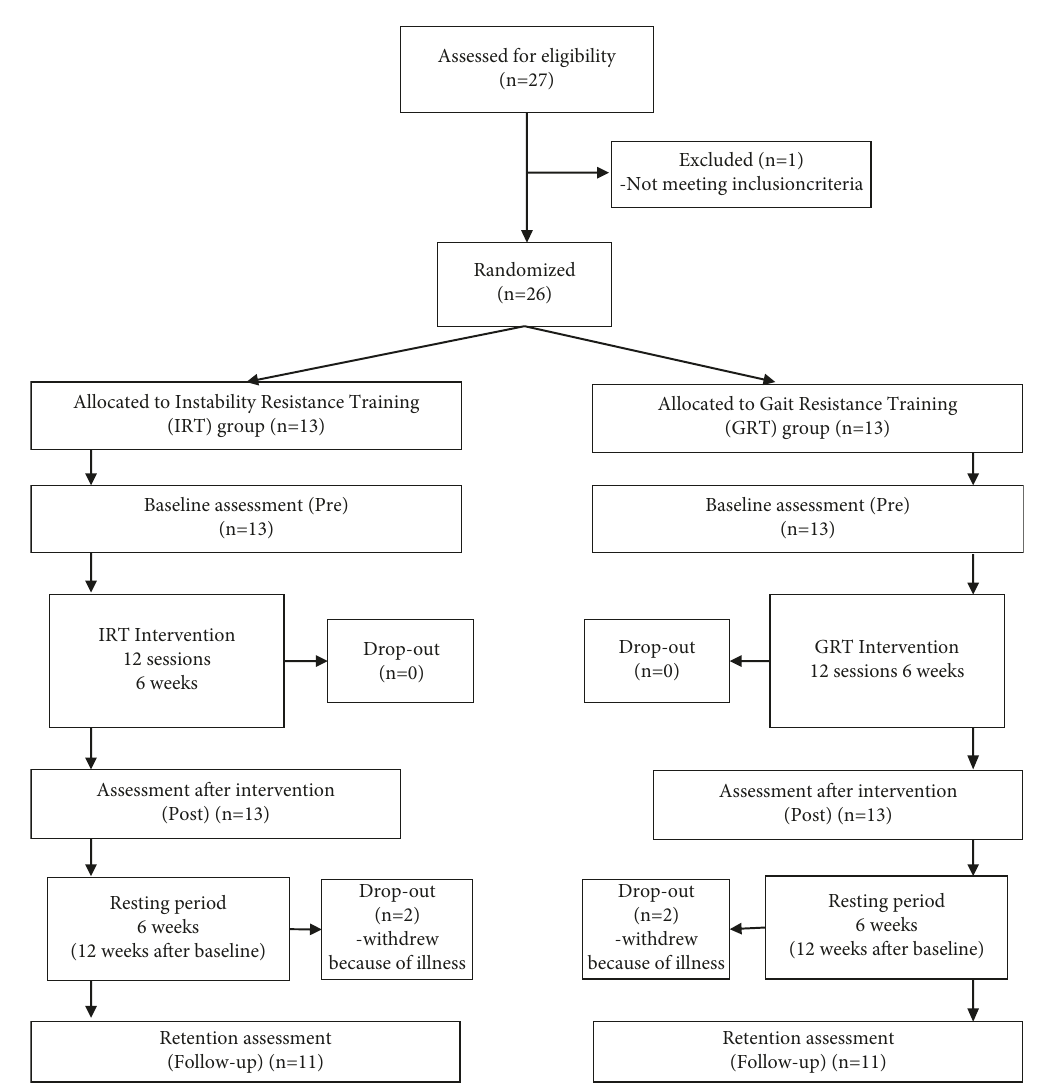
Figure 2: Study Design. Eligible participants were randomly allocated to one of the two groups and clinically assessed at the baseline. After (post) the six-week long intervention, participants were assessed again. Patients were called in again after a resting period of 6 weeks to undergo a follow-up